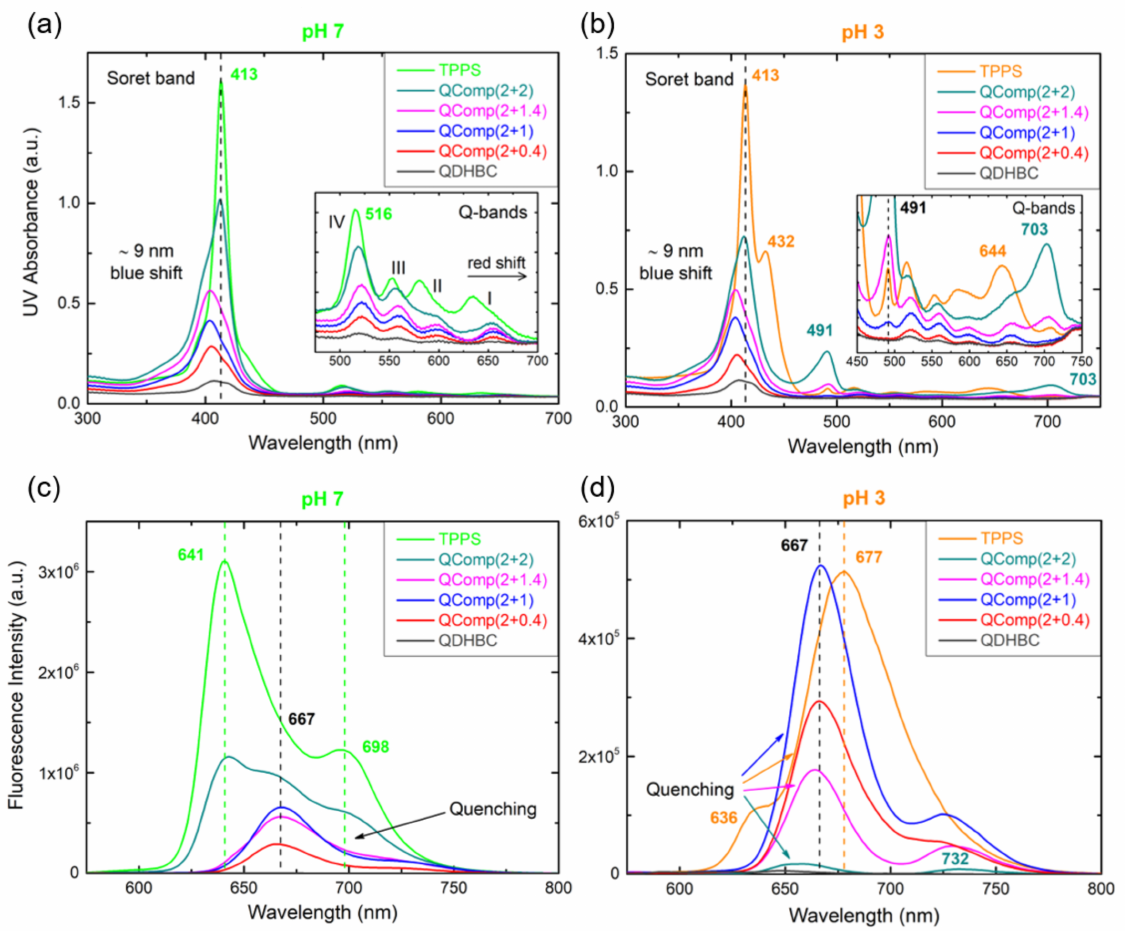
Figure 7. UV-vis ( a , b ) and fluorescence ( c , d ) spectra of the QDHBC/TPPS complex solutions at pH 7 (left) and 3 (right). The insets in the top row show a scaling up of the Q-bands area. The corresponding spectra of neat TPPS and QDHBC are also included for